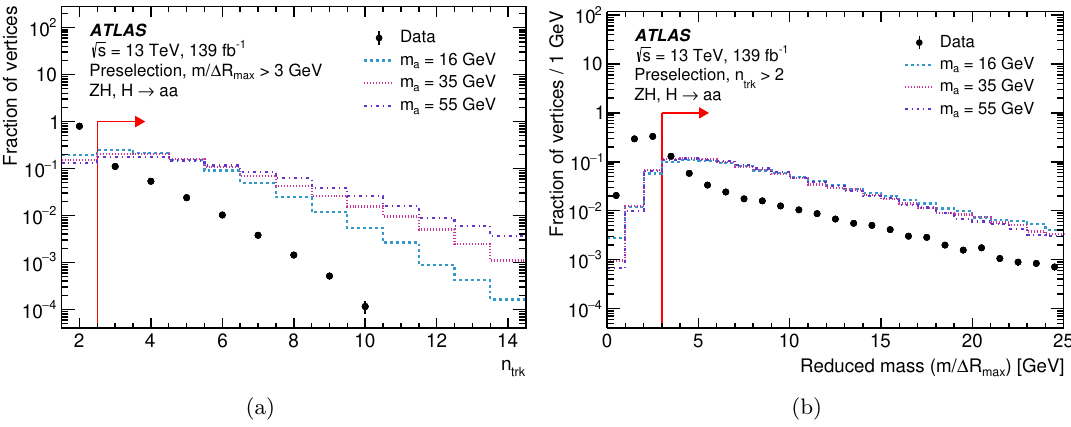
Figure 2 . The distribution of (a) n trk for preselected DVs with reduced mass exceeding 3 GeV and (b) reduced mass for preselected DVs with n trk > 2 , in simulated signal samples (dashed lines) and a background-enriched data sample (black points). DVs in events satisfying the control region selection, defined in section 5, are considered. An arrow indicates the selection requirement which is applied to the observable. The distributions are normalized to unit